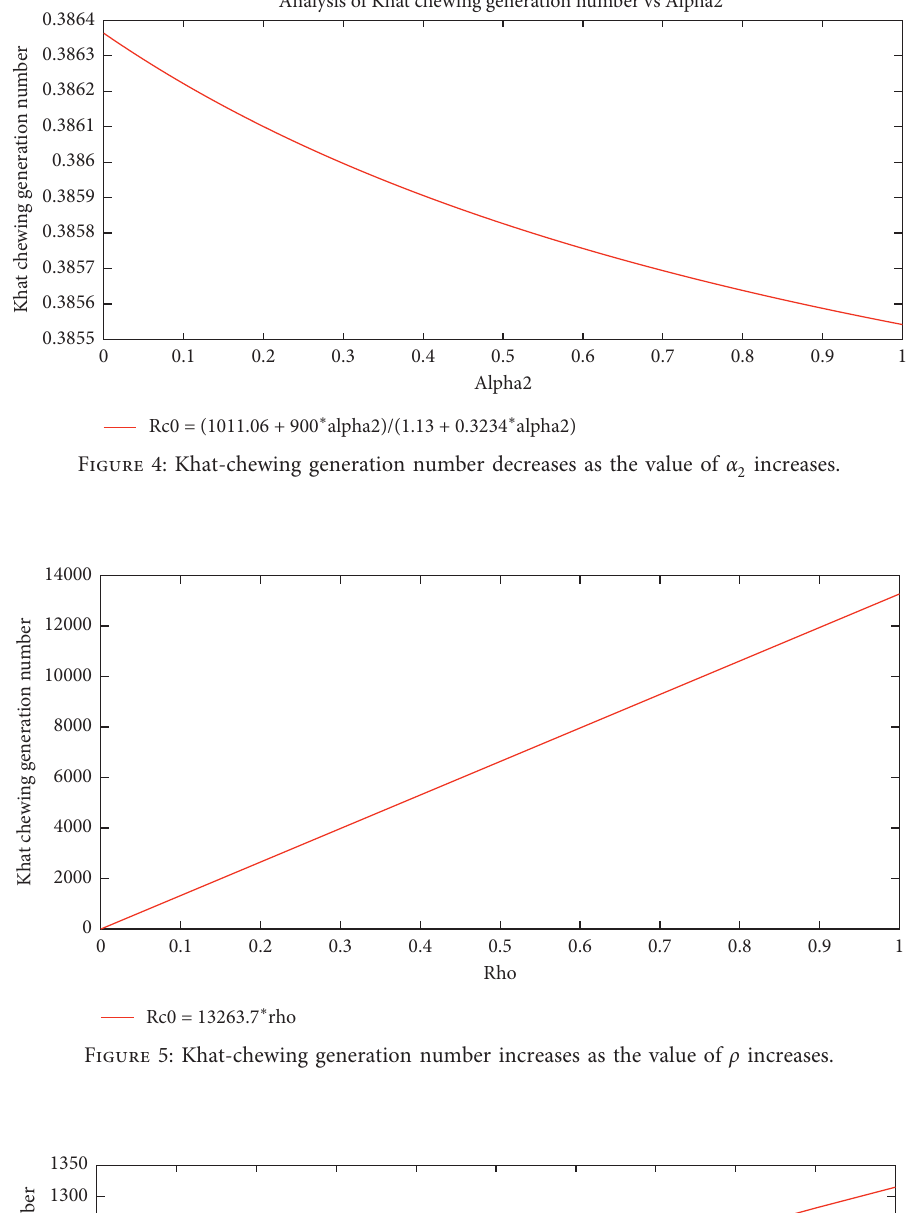
Figure 5: Khat-chewing generation number increases as the value of ρ increases.